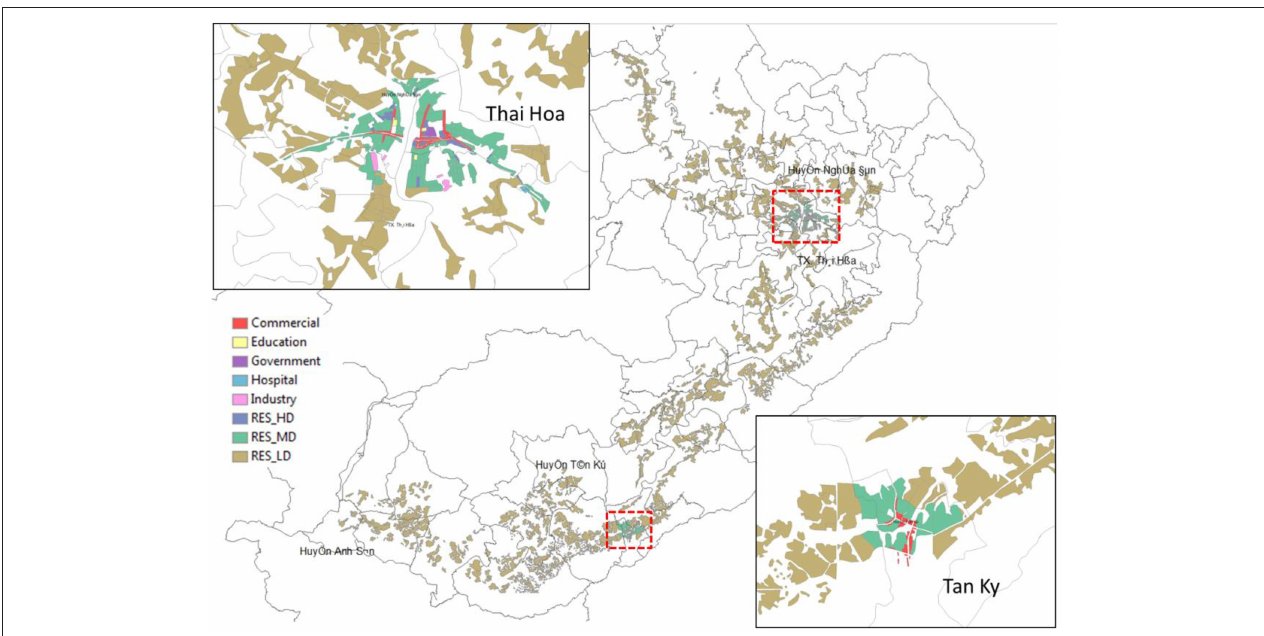
FIGURE 8 | Sampled areas (Thai Hoa and Tan Ky) and the whole study area [the Hieu River region (in brown